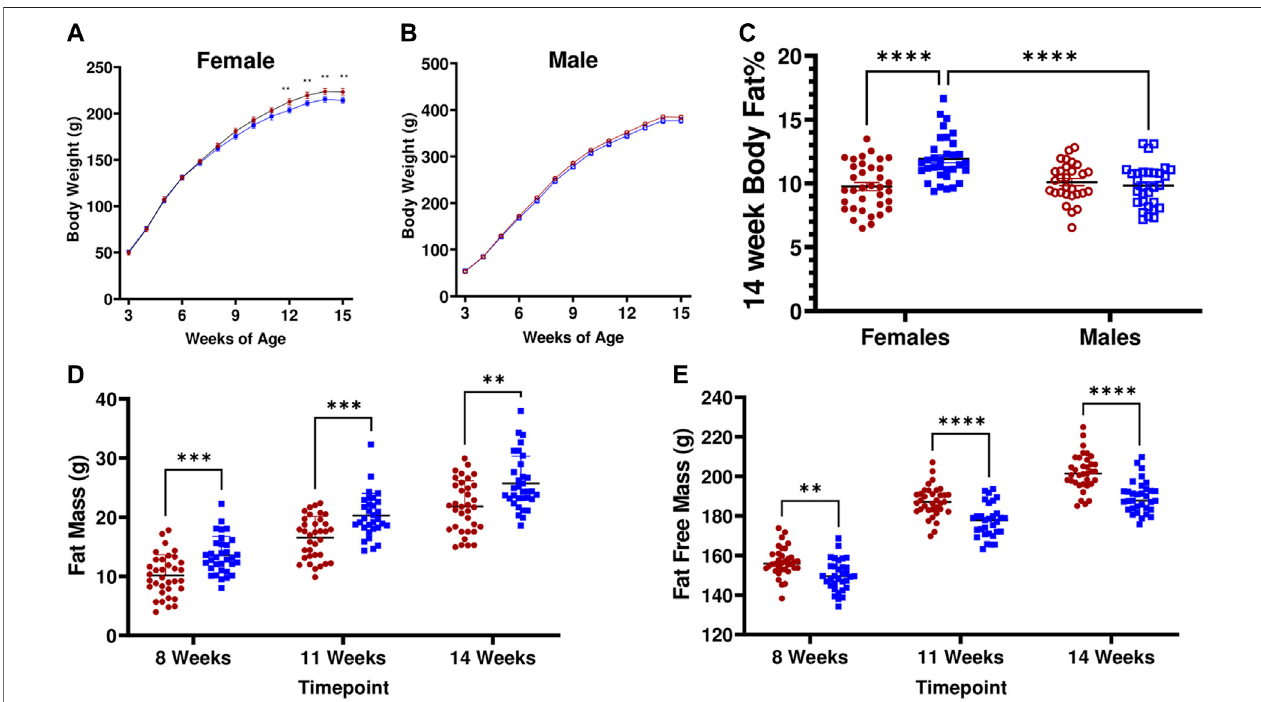
FIGURE2| LH 17 LNacongenicratsdisplayfemale-speci fi cincreasesinadiposityandaltered bodycomposition. (A) LH 17 LNacongenicfemales(bluesolidsquare, n = 33) and LH control females (red solid circle, n = 35) develop decreased body weights starting at 12 weeks of age (Two-Way ANOVA, with Sidak ’ s correction for multiple comparisons; strain ( p = 0.0203) and time x strain ( p < 0.0001)). Timepoints which were signi fi cant after Sidak ’ s correction are indicated by ** ( p < 0.01). (B) LH 17 LNa congenic males (blue open square, n = 30) and LH control males (red open circle, n = 29) displayed no differences in body weight. (C) LH 17 LNa females exhibitsigni fi cantsex-speci fi ceffectsonbodyfat%(p sex < 0.01,p strain < 0.01,p interaction < 0.0001),whilenodifferencesbetweenmaleLHcontrolsandLH 17 LNacongenics were noted. (D,E). LH 17 LNa females demonstrated increased fat mass (p strain < 0.0001), and decreased fat free mass (p strain < 0.0001, p interaction < 0.001) at all measured timepoints (Mixed model with Sidak ’ s correction for repeated